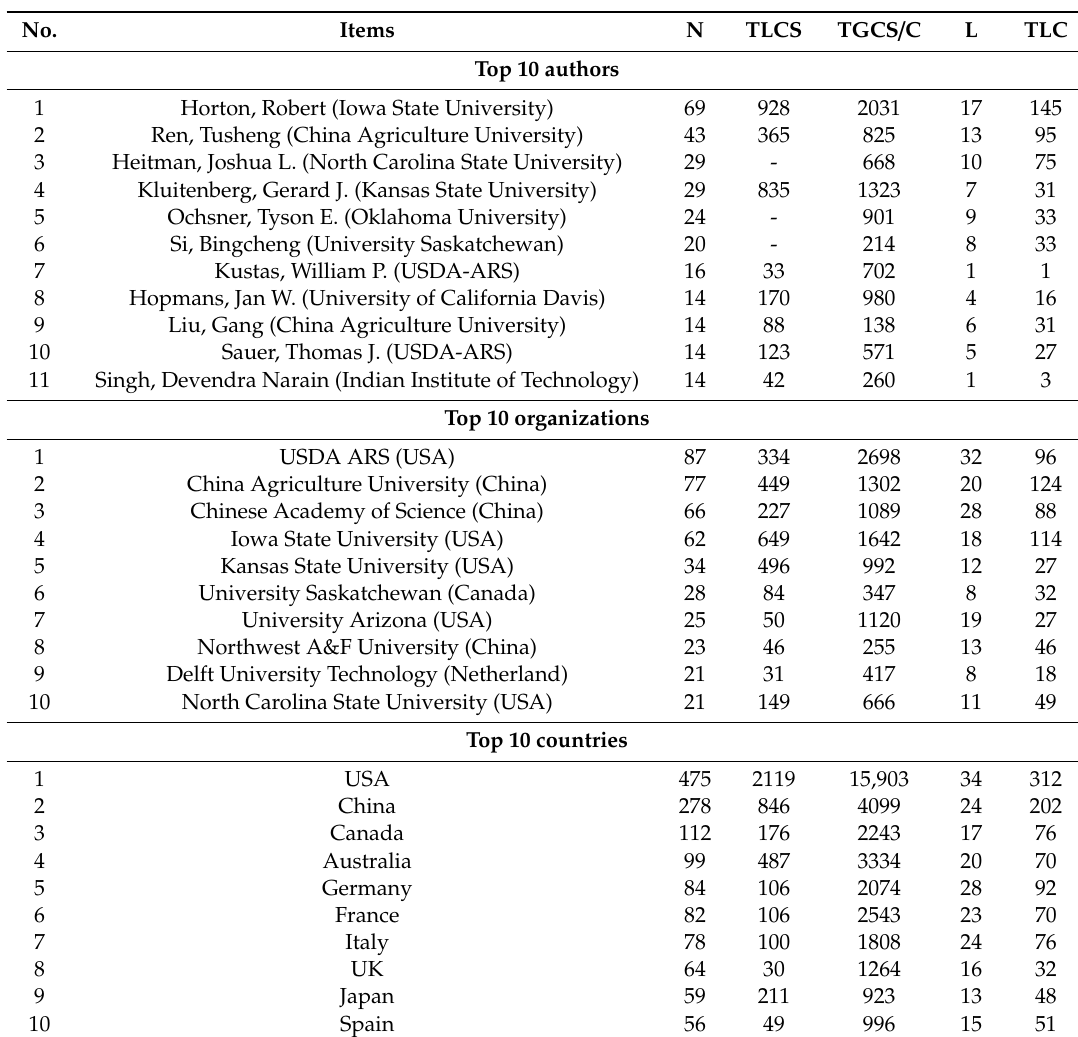
Table 1. Top 10 authors, organizations and countries commits to publications on heat pulse method for soil physical measurement with a threshold of minimum five publications per author. The HistCite indices are number of publications (N), total local citation score (TLCS, times to be cited by the 1319 papers) and total global citation score (TGCS, times to be cited by the Web of Science Core Collection). The VOSviewer indices are links (L, the number of collaborations or lines between investigated author / country / organization), total link strength (TLS) and citations (C). Value of TGCS is equal to C (TGCS /